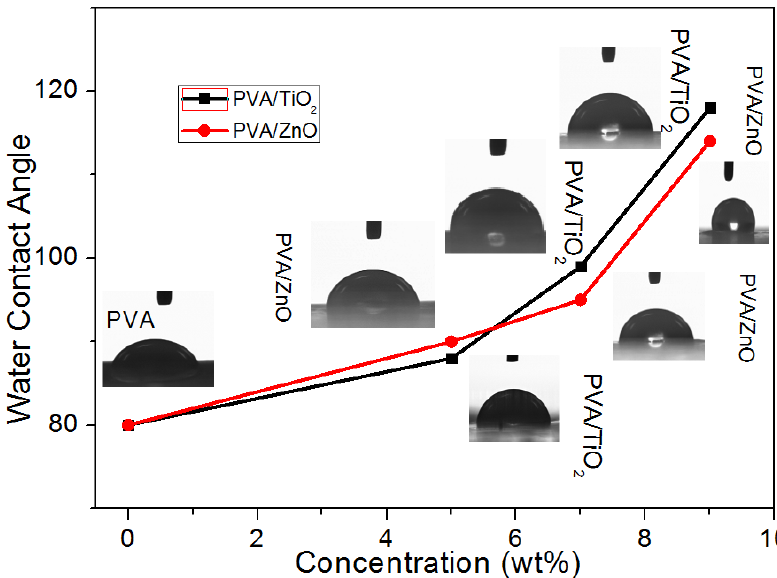
Figure 7. Wetting behavior of Neat PVA nanofibers; 5% PVA/ZnO nanofibers; 7% PVA/ZnO nanofibers; 9% PVA/ZnO nanofibers; 5% PVA/TiO 2 nanofibers; 7% PVA/TiO 2 nanofibers; (g) 9% PVA/TiO 2 nanofibers.